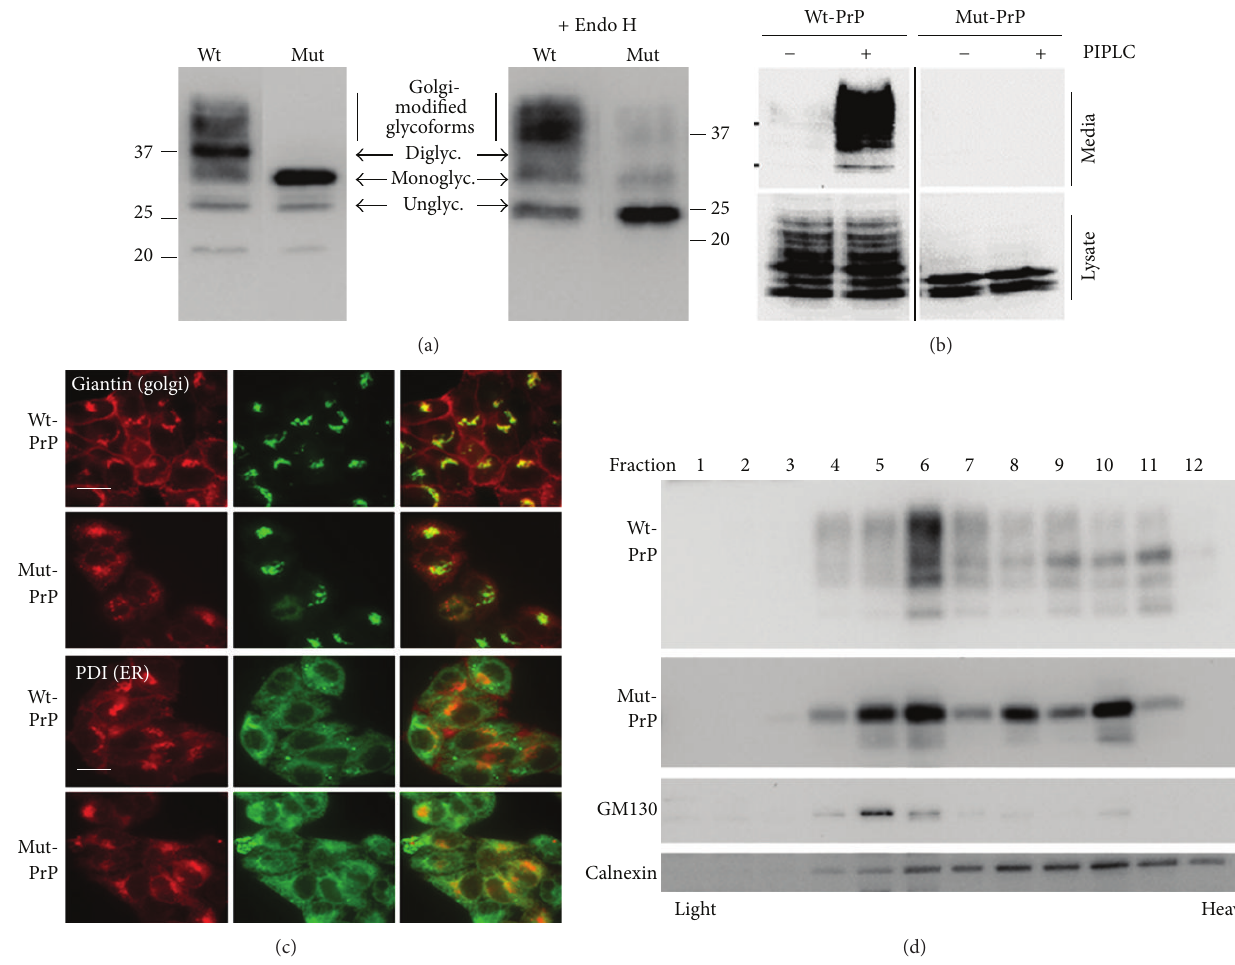
Figure 1: Aberrant trafficking of PrP-T182A. (a) Western blot of whole cell lysates prepared from N2a cells transiently expressing either Wt- or Mut-PrP carrying the 3F4 epitope (i.e., PrP(3F4)) for 16h, before and after digestion with Endoglycosidase H (Endo H), followed by probing with 3F4 mAb. Wt-PrP has two N-linked glycosylation sites at positions 180 and 196, producing un-, mono-, and diglycosylated PrP. The T182A mutation disrupts the N-X-T glycosylation consensus site, resulting in loss of diglycosylated PrP. The lower molecular weight fractions of Wt-PrP and the core-glycosylated fraction of Mut-PrP are sensitive to Endo H, whereas higher molecular weight, Golgi-modified glycoforms, is resistant. (b) Western blot of Wt- and Mut-PrP recovered from the media (top) or lysates (bottom) of COS-7 cells transiently expressing PrPs for 16h and then incubated for 90 min at 4 ∘ C in OptiPro media in the absence ( − ) or presence of PIPLC (+). Wt-PrP was detected in the media of PIPLC treated cells, whereas Mut-PrP was not (top panels), although the expression of each was evident in cell lysate preps (bottom panels), as revealed by D13 F (ab) anti-mouse-PrP antibody. (c) Immunofluorescence confocal microscopy of N2a cells expressing either Wt- or Mut-PrP(3F4) (red), costained for giantin or PDI (green). In contrast to Wt-PrP, Mut-PrP is consistently absent from the plasma membrane although it does label the ER and Golgi, indicating limited trafficking to at least cis-Golgi. Scale bars = 12 𝜇 m. (d) Sucrose gradient subcellular fractionation of N2a cells stably expressing Wt- or Mut-PrP(3F4) shows that Mut-PrP is distributed primarily in heavier fractions that correspond with the ER marker calnexin, compared with Wt-PrP that cofractionates primarily with the Golgi marker GM130. PrP is detected with 3F4